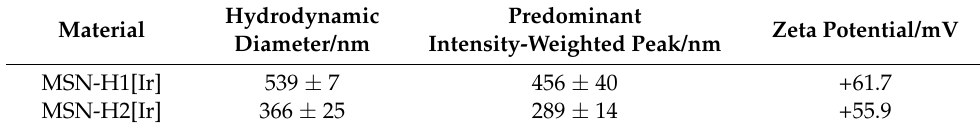
Figure 3. ( a ) FTIR spectra of MSN-H1[Ir] and MSN-H2[Ir] (Cp* = pentamethylcyclopentadienyl), along with the spectra of previously reported precursor materials (MSN, MSN-AP, MSN-PA, MSN-H1,